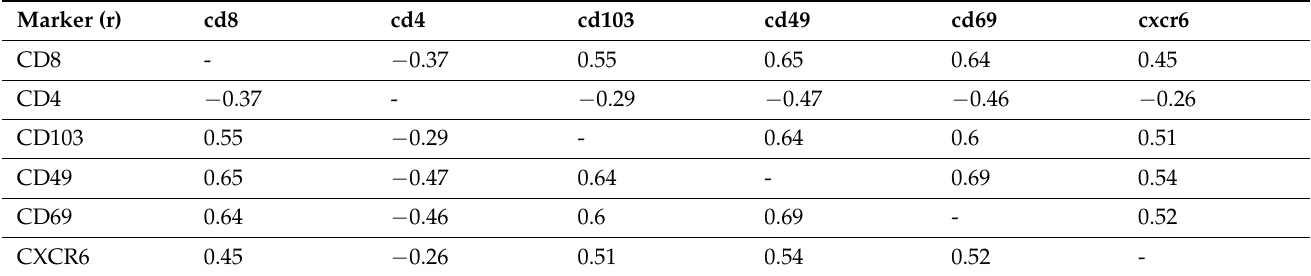
Table 2. Correlations (r, p < 0.05) between individual markers in the study group of patients with psoriasis. Marker